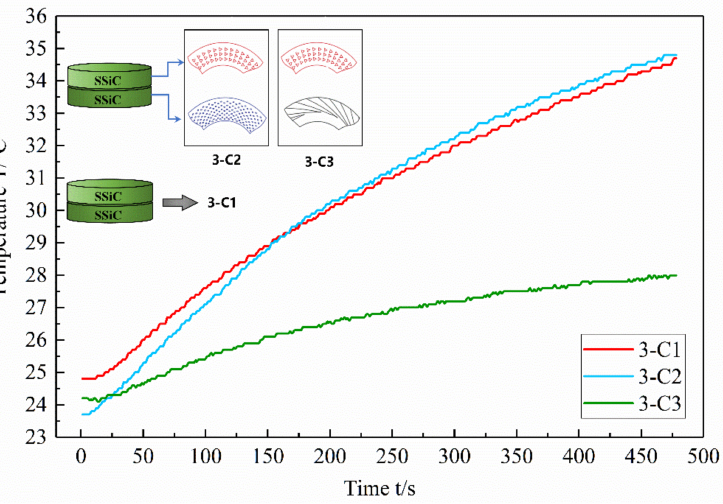
Figure 11. Surface temperature of friction pairs with bi-composite surface texture configurations under 250